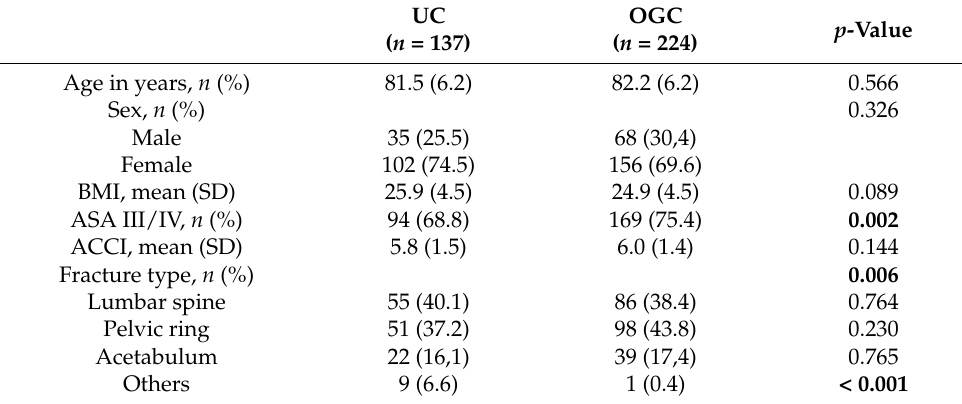
Table 1. Demographic characteristics.